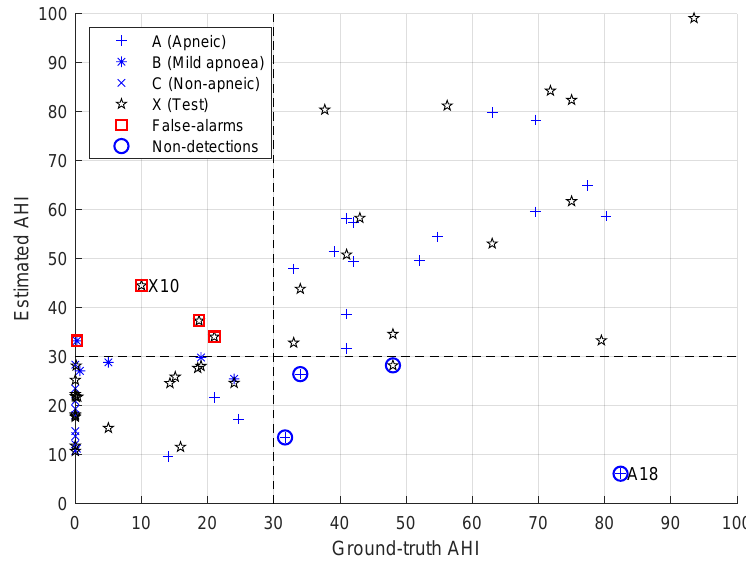
Figure 12. Method’s output on PhysioNet